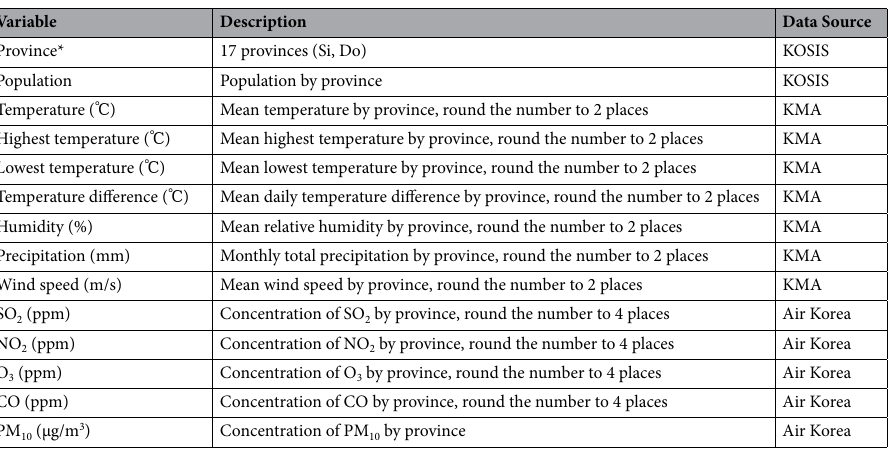
Table 4. Basic variables from government-provided big data. SO 2 , sulfur dioxide; NO 2 , nitrogen dioxide; O 3 , Ozone; CO, carbon monoxide; PM 10 , levels of particulate matter with aerodynamic diameter < 10 μm; KOSIS, Korean Statistical Information Service; KMA, Korea Meteorological